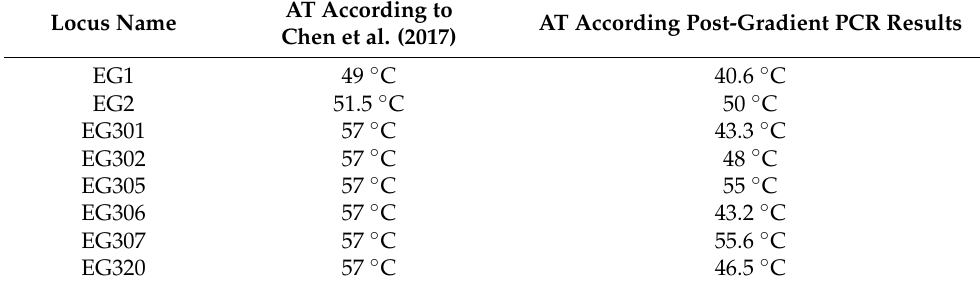
Table 3. Comparison between the annealing temperature (AT) of Simple Sequence Repeat markers in Echinochloa crus-galli according to Chen et al. (2017) and annealing temperature determined by post-gradient PCR results.